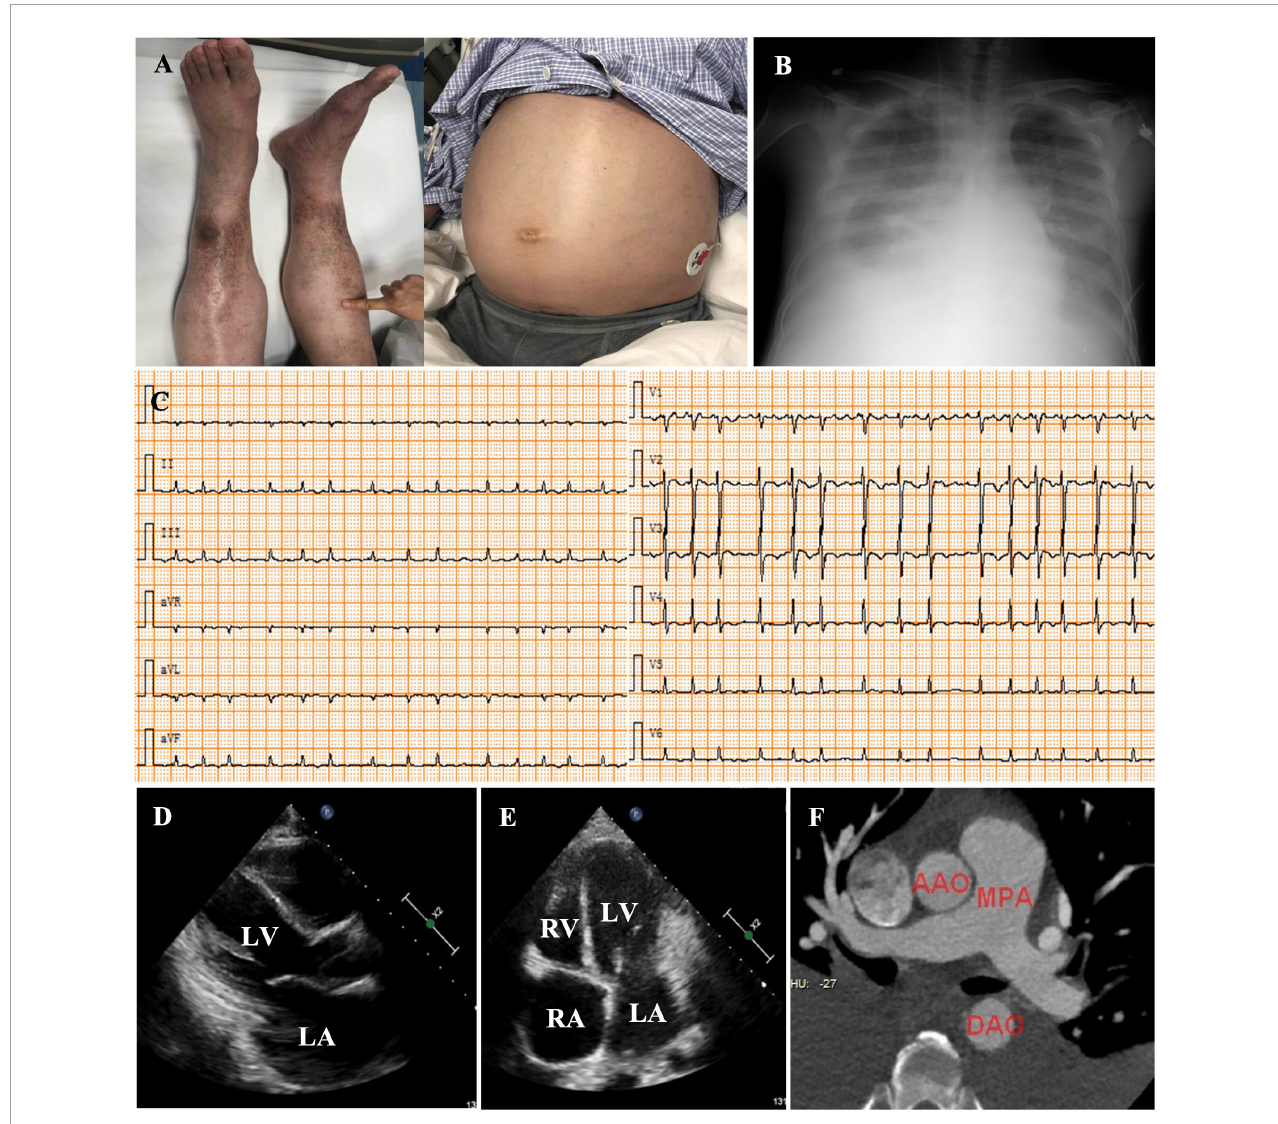
FIGURE1 Physical examination revealed pitting edema of the lower extremities and abdominal distension (A) . Chest radiology showed a pleural effusion (B) . Electrocardiography (ECG) at admission indicated the diagnosis of atrial fibrillation (AF) [heart rate (HR), 134 bpm] with low voltage in all leads (C) . Echocardiography showed left (D) and RA enlargement (E) , and a normal LV chamber. Cardiac computed tomographic angiography of the pulmonary arteries excluded pulmonary embolism (F) . LV, left ventricle; RV, right ventricle; LA, left atrium; RA, right atrium; AAO, ascending aortic artery; MPA, main pulmonary artery; DAO, descending aortic